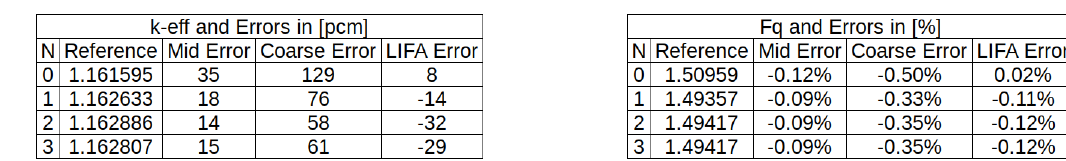
Table 5: Multiphysics k Results Table 6: Multiphysics Peaking Factors eff